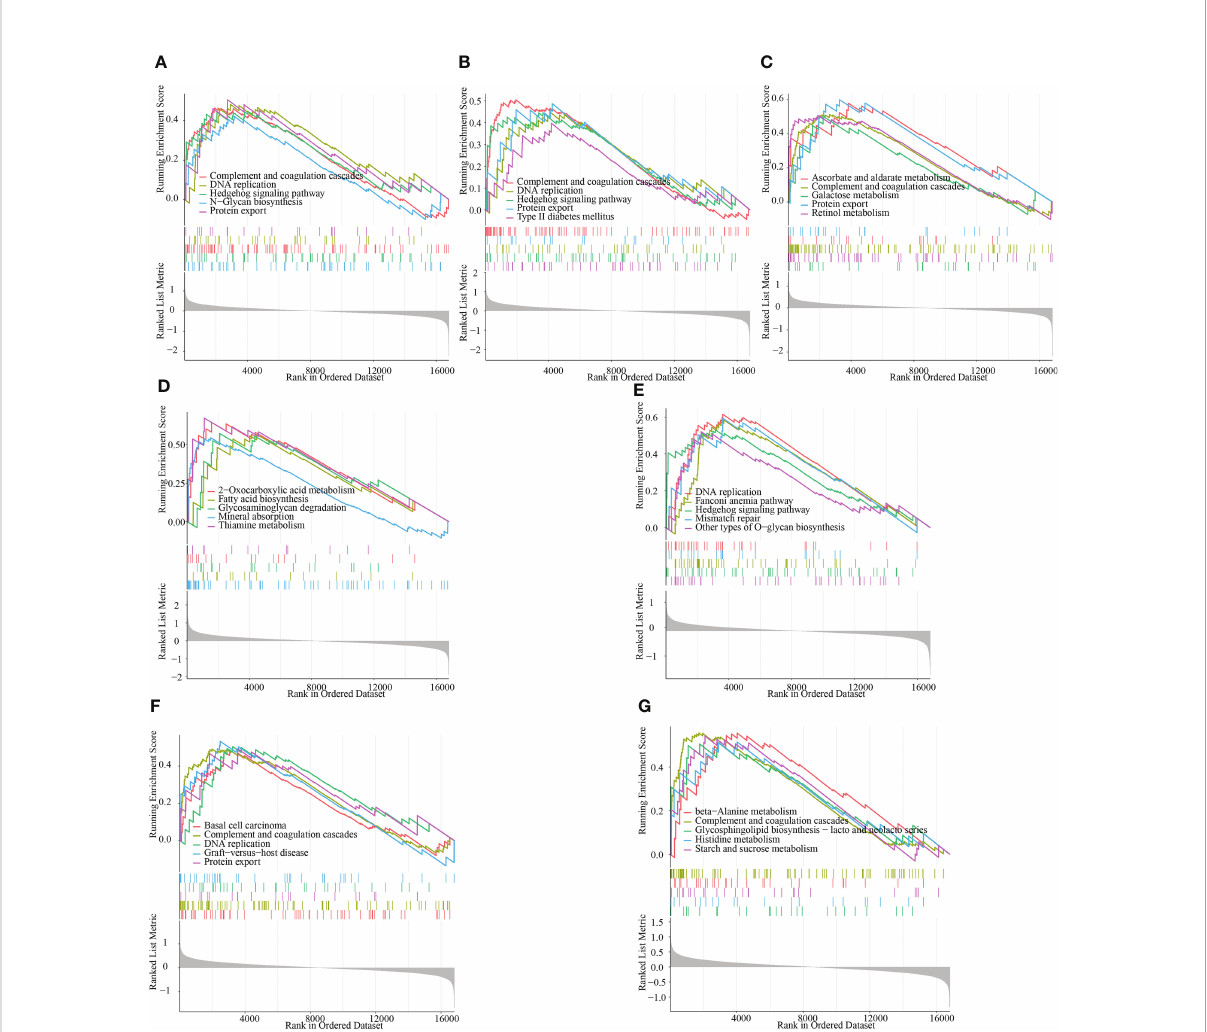
FIGURE 8 GSEA identi fi es the signaling pathways that are impacted by the target genes. (A – G) The main signaling pathways that are signi fi cantly enriched by the high expression of the target genes in the GSE165004 dataset. (A) ACTR2, (B) CD2AP, (C) MBNL2, (D) NCSTN, (E) PUM1, (F) RPN2 and (G)